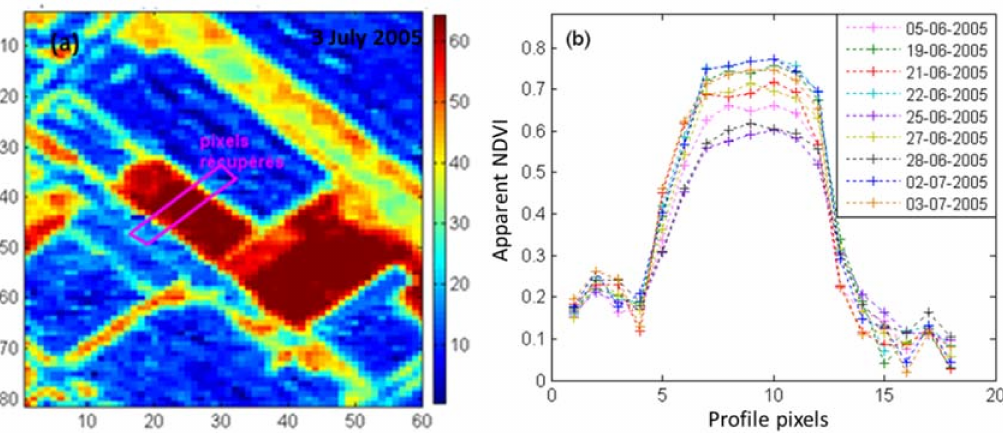
Figure 17. Profile of apparent NDVI (normalized difference vegetation index) extracted over the width of the plant surface selected on the Formosat-2 images that were